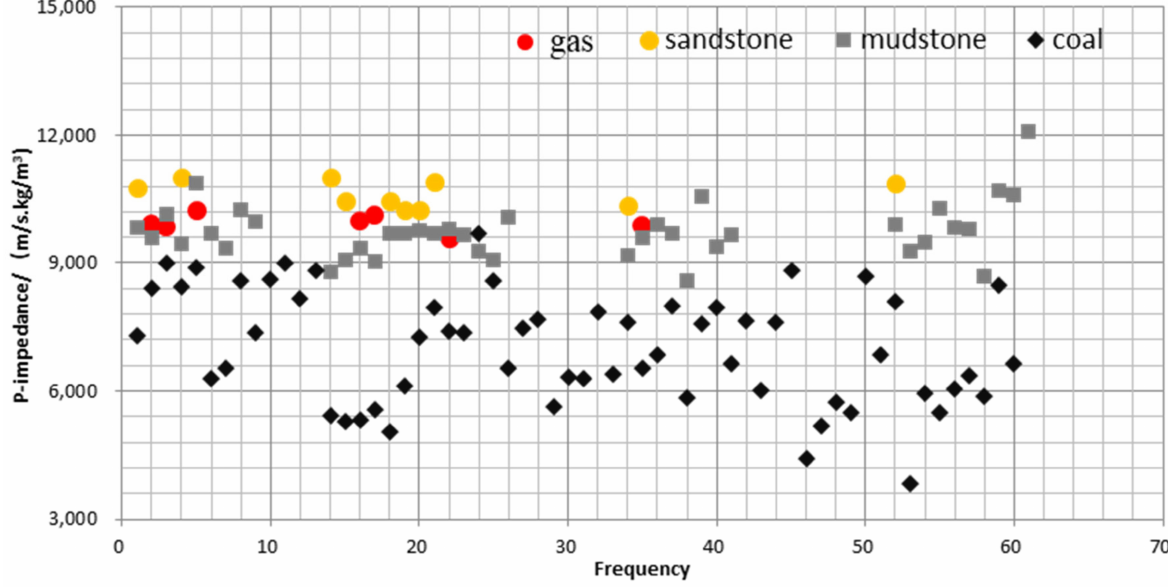
Figure 3. P-impedance distribution characteristics of different lithologies.